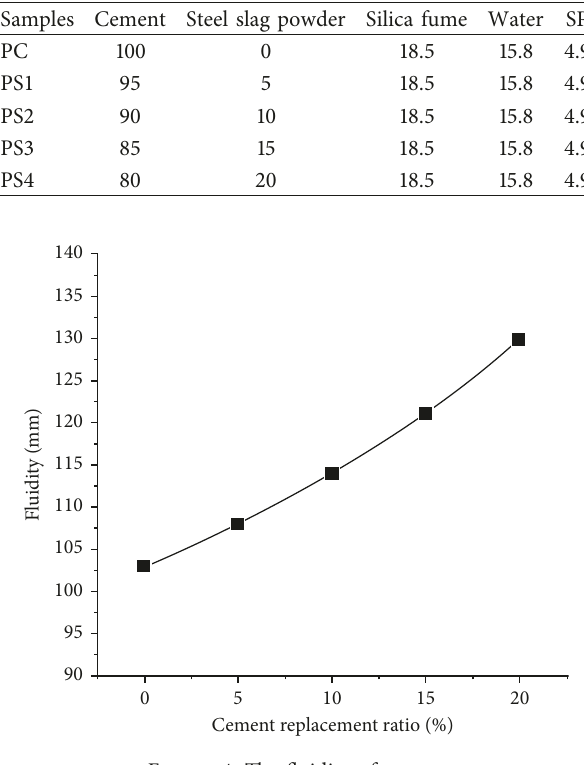
Figure 4: The fluidity of pastes.